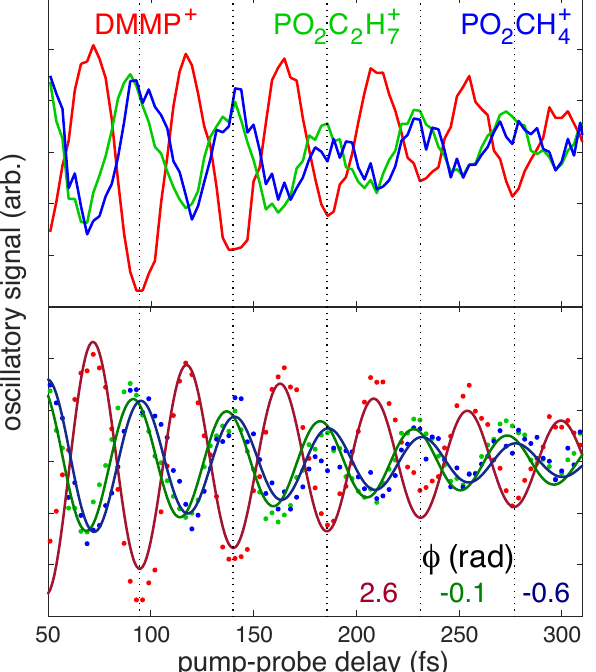
Figure 2. Oscillatory ion signals of DMMP + (red), PO as raw signals ( top ) and fit to exponentially decaying cosine functions ( bottom ). The extracted phases for each signal are shown; all signals had an oscillation period of 45.5